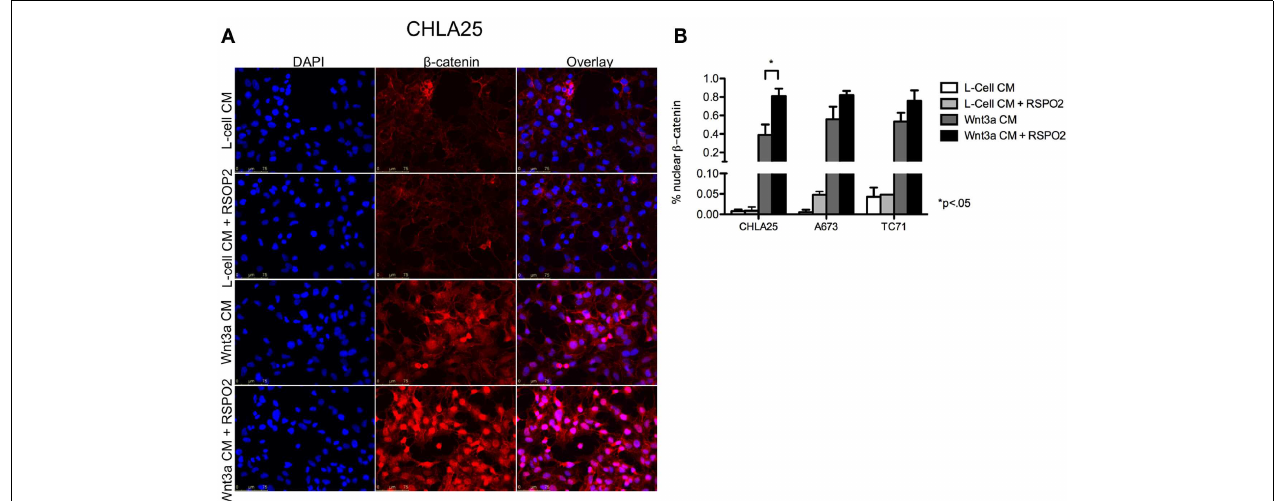
effect on β -catenin nuclear localization. (B) The percentage of CHLA25, A673, andTC71 cells with nuclear β -catenin all increased withWnt3a CM, but CHLA25 showed the greatest increase in nuclear localization with the addition of RSPO2. Data from three independent experiments and error bars are SEM.